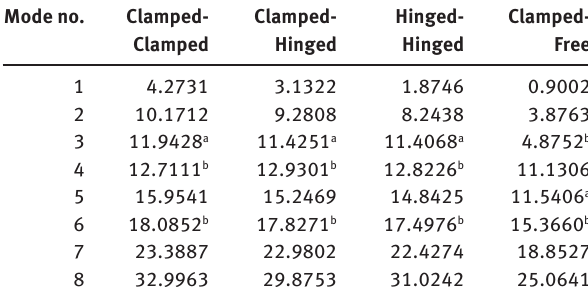
delaminated beams ( L/h = 15). s